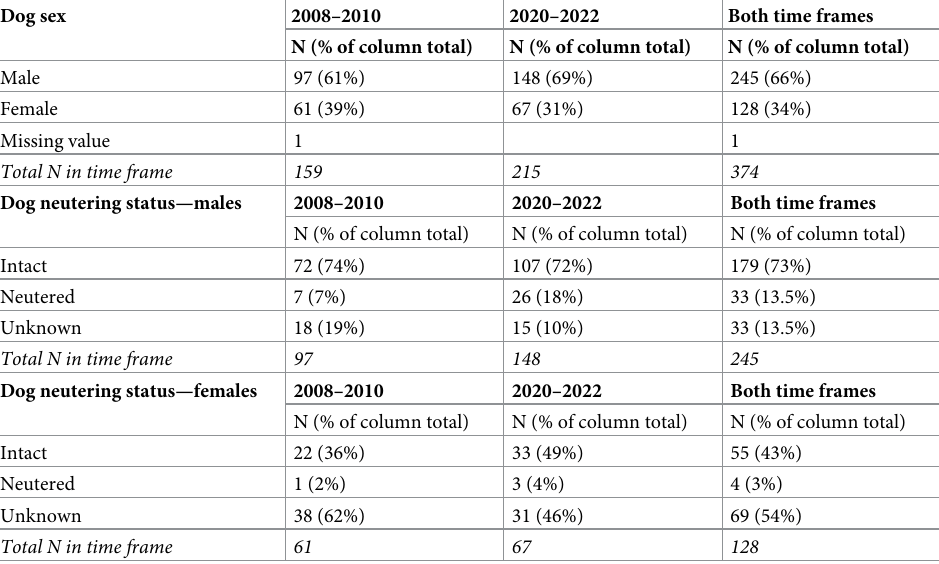
Table 3. Descriptive data on sex and neutering status of confiscated dogs. Dog sex as count and as % of column total for a first time frame (2008–2010), a second time frame (2020-mid-May 2022) and overall for both time frames, for 374 dogs confiscated after a biting incident.